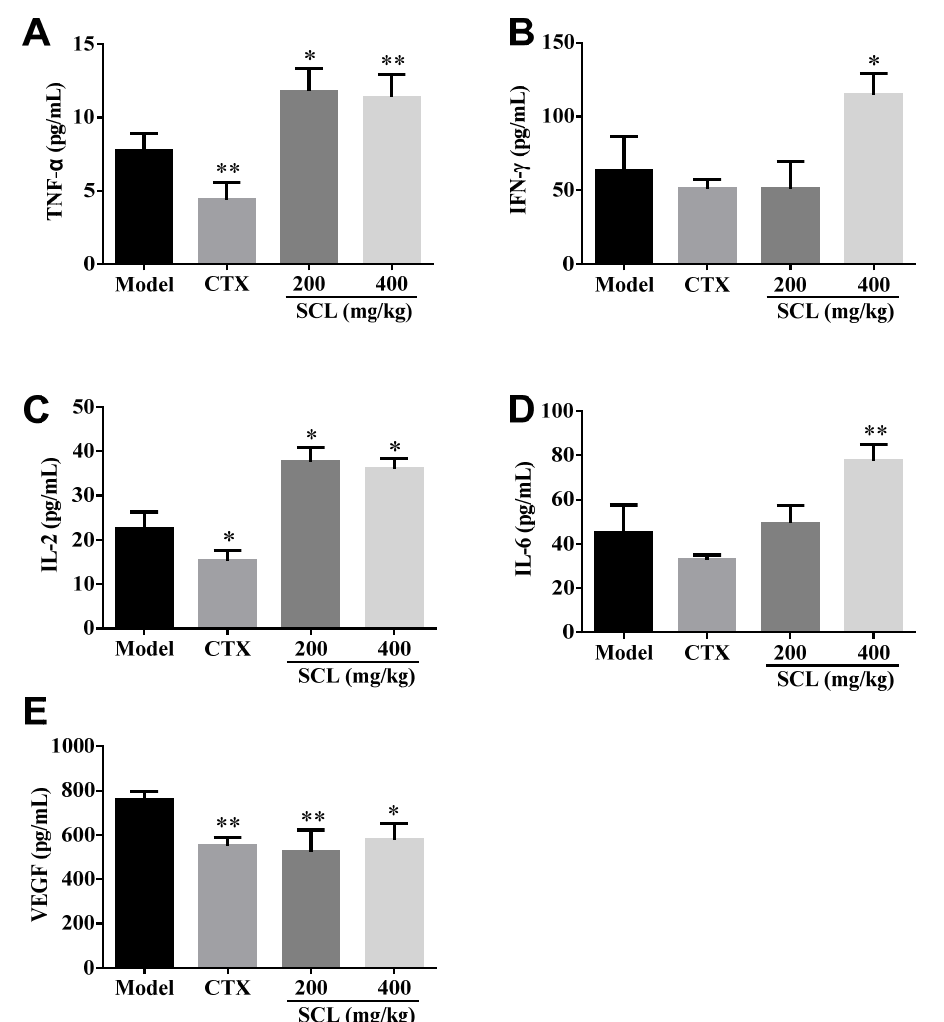
Figure 3. Effects of steamed C . lanceolata (SCL) on the levels of serum cytokines, including tumor necrosis factor- α (TNF- α ) ( A ), interferon- γ (IFN- γ ) ( B ), interleukin-2 (IL-2) ( C ), interleukin-6 (IL-6) ( D ) and vascular endothelial growth factor (VEGF) ( E ) in H22 tumor-bearing mice. All data were expressed as the mean ± standard deviation (SD), n = 10. * p < 0.05, ** p < 0.01 vs. the model group.